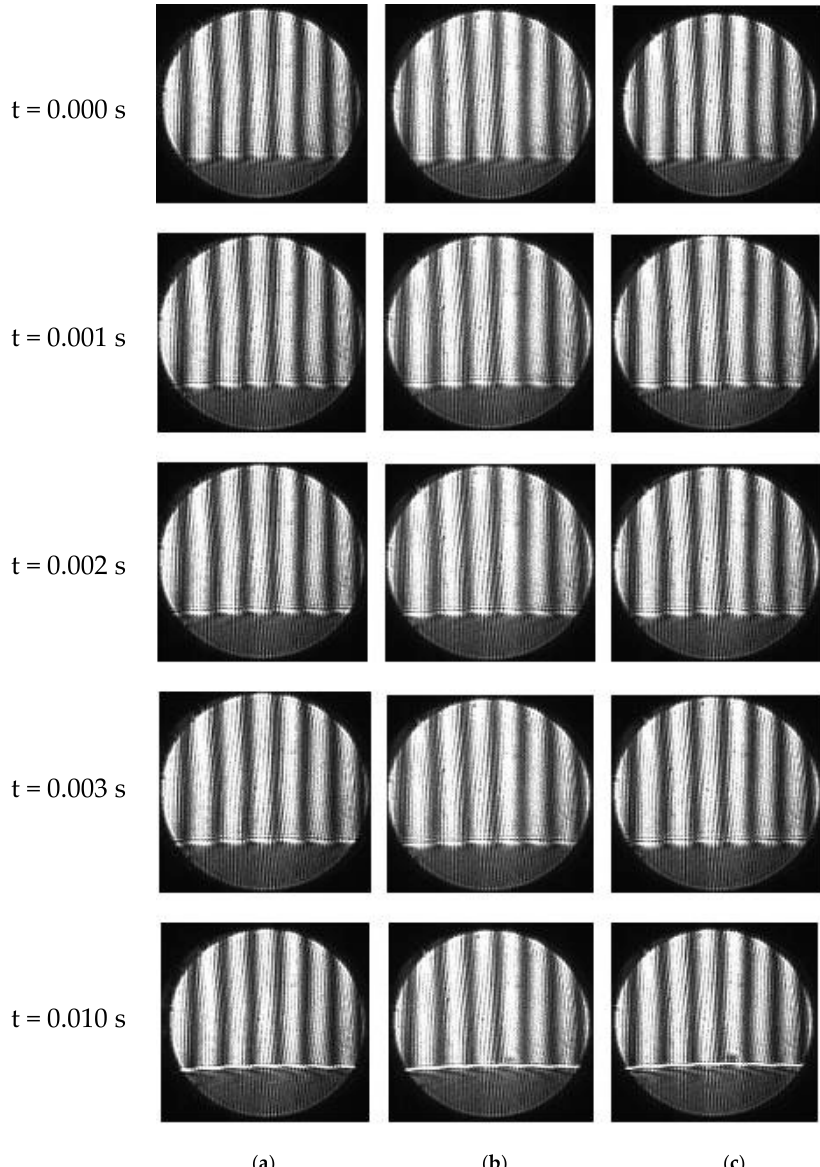
Figure 5. Temporal variations of interferogram with nickel sheet (finite fringe, δ = 0.0075 mm). ( a ) 17 V, ( b ) 19 V, ( c ) 21 V.